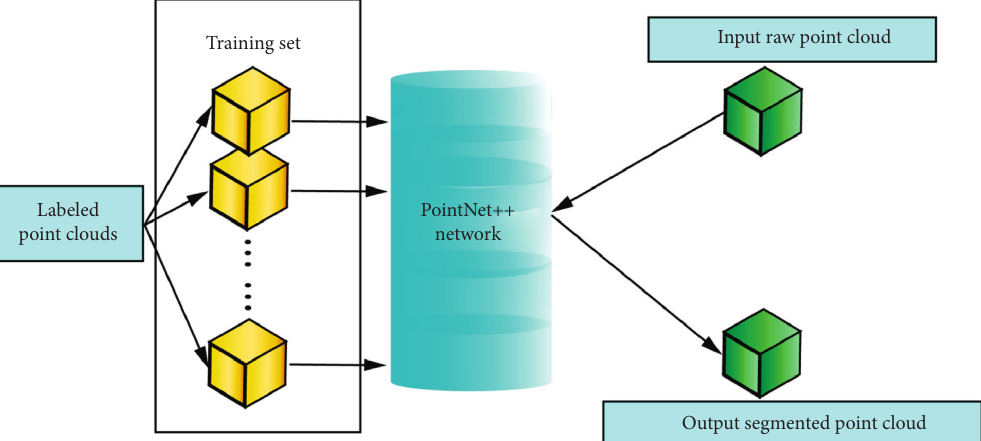
Figure 13: PointNet++ network training and application.